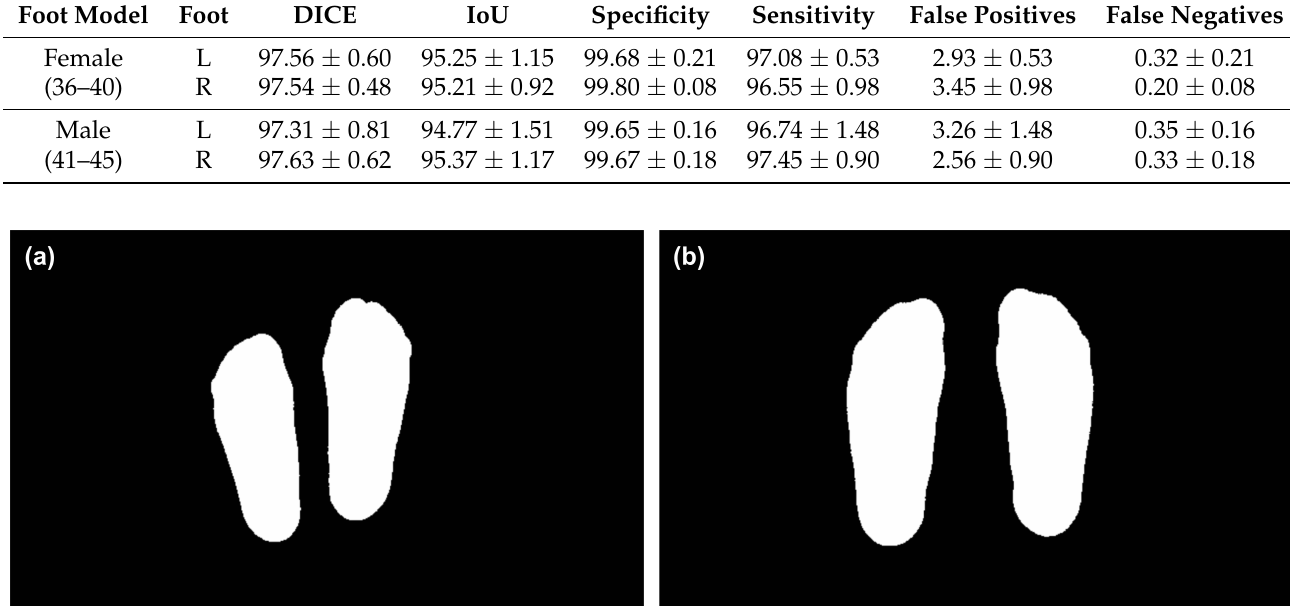
Figure 3. Masks corresponding to the model extracted using all the available female ( a ) and male ( b ) European shoe